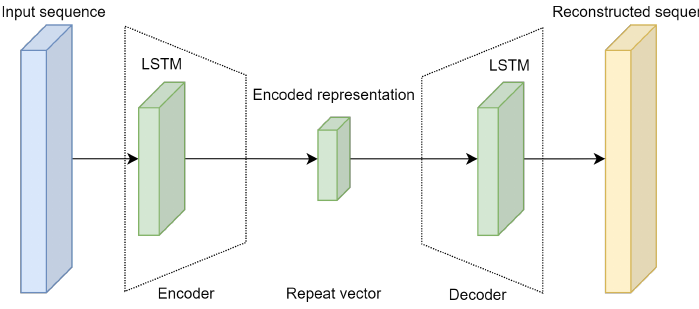
Figure 3. A high-level representation of an LSTM